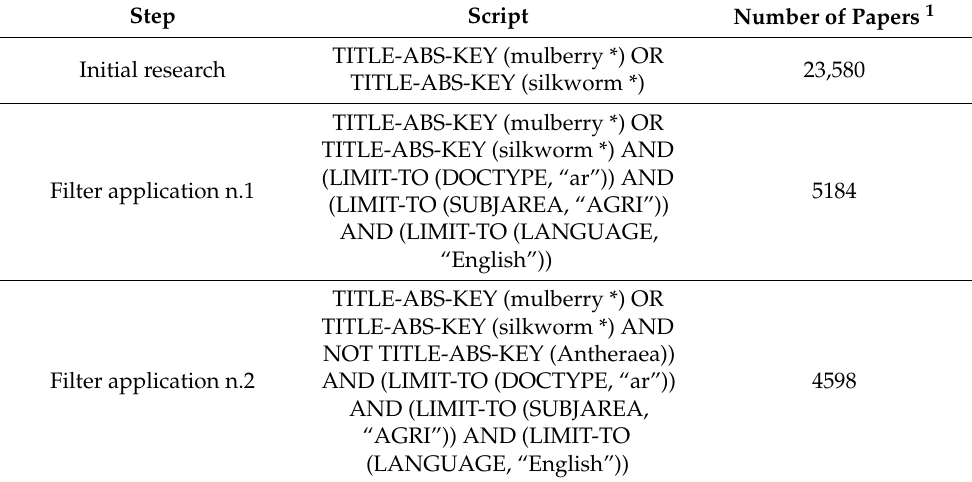
Table 1. Scripts for the extraction of research papers in the SCOPUS database. Step Script Number of Papers 1 Initial research